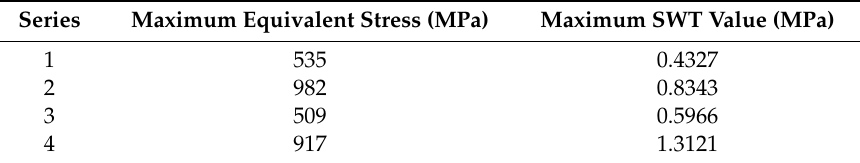
Table 5. Finite element results.